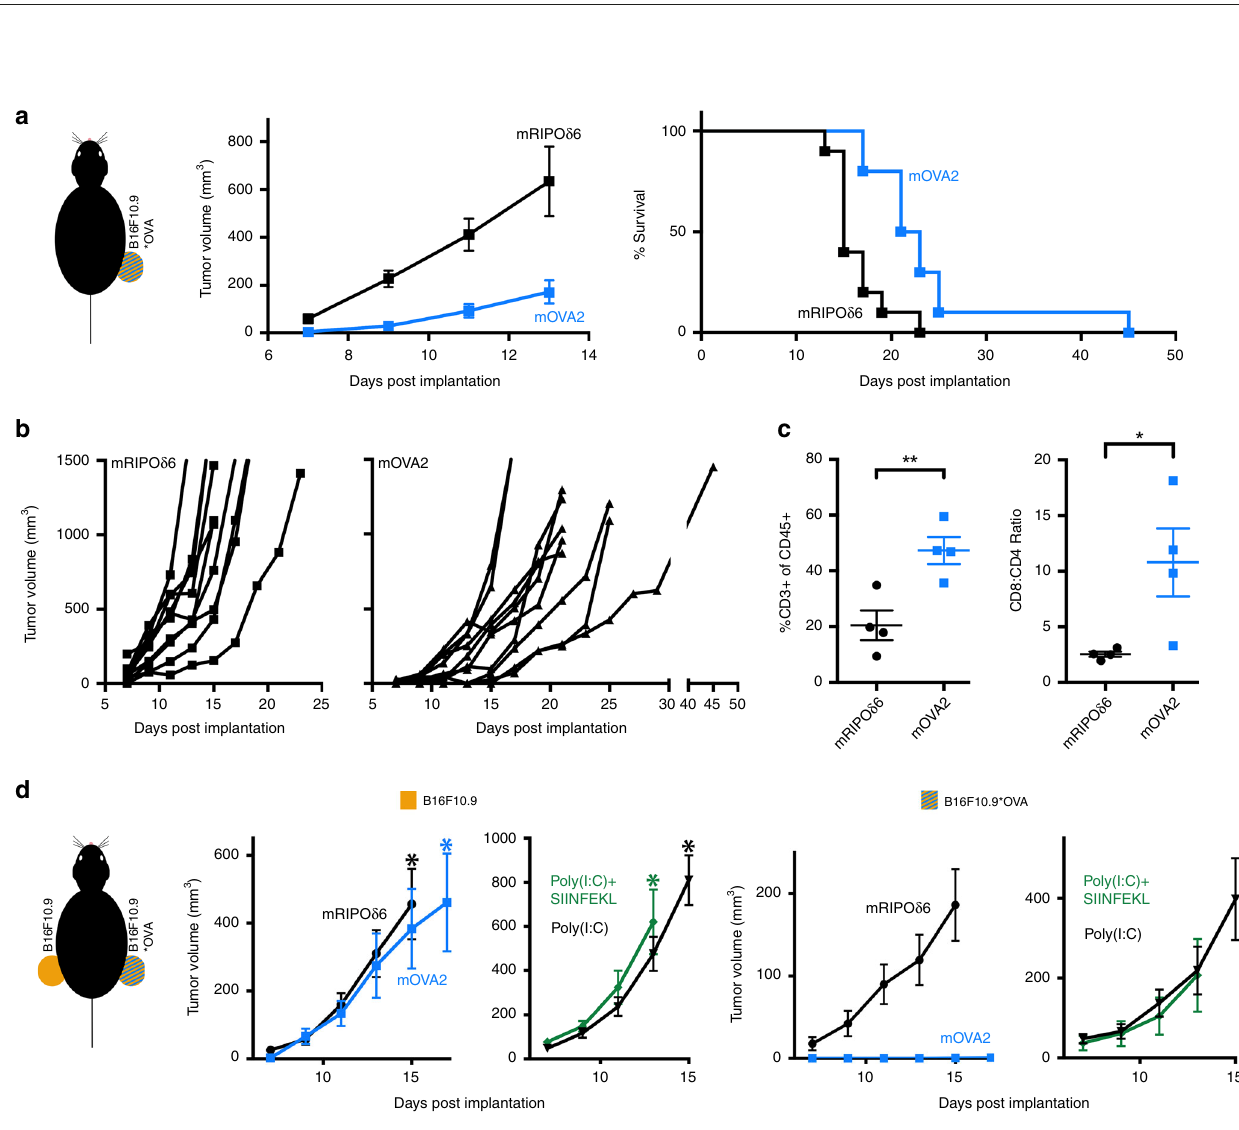
Fig. 6 mOVA2 immunization delays tumor growth and induces tumor CD8 T cell in fi ltration. a Mice were immunized with either mOVA2 or mRIPO δ 6 on day 0, boosted on day 14, B16F10.9-OVA cells were implanted subcutaneously 3 weeks later, and tumor volumes were monitored (mice were euthanized when tumors reached 1000 mm 3 ). mOVA2-immunized mice survived signi fi cantly longer than mRIPO δ 6 treated animals [ P = 0.0017, Log-rank (Mantel-Cox) test, n = 10]. A repeat assay including a mock-immunized group is shown in Supplementary Fig. 18. ( b ) Tumor progression in individual mice from experiment in ( a ). c B16F10.9-OVA tumors from mOVA2-immunized mice had elevated CD8 T cell in fi ltration compared to mRIPO δ 6-immunized mice. The gating strategy is shown in Supplementary Fig. 17. Two-tailed t-test, n = 4. * P < 0.05, ** P < 0.01. d The anti-tumor effect of mOVA2 immunization correlates with SIINFEKL CD8 T cell frequency and is speci fi c to tumors expressing OVA. Mice were immunized with mRIPO δ 6, mOVA2, poly(I:C), or poly(I:C) + SIINFEKL as in Fig. 5a, followed by bilateral B16F10.9 and B16F10.9-OVA tumor implantation as shown (left panel). Tumor progression was monitored until reaching >1000 mm 3 in the fi rst test animal (asterisks; this occurred in the contralateral B16F10.9 tumors in all treatment groups). mRIPO δ 6 n = 9, mOVA2 n = 8, poly(I:C) + SIINFEKL n = 8, poly(I:C) n = 10. All error bars represent SEM; n = number of